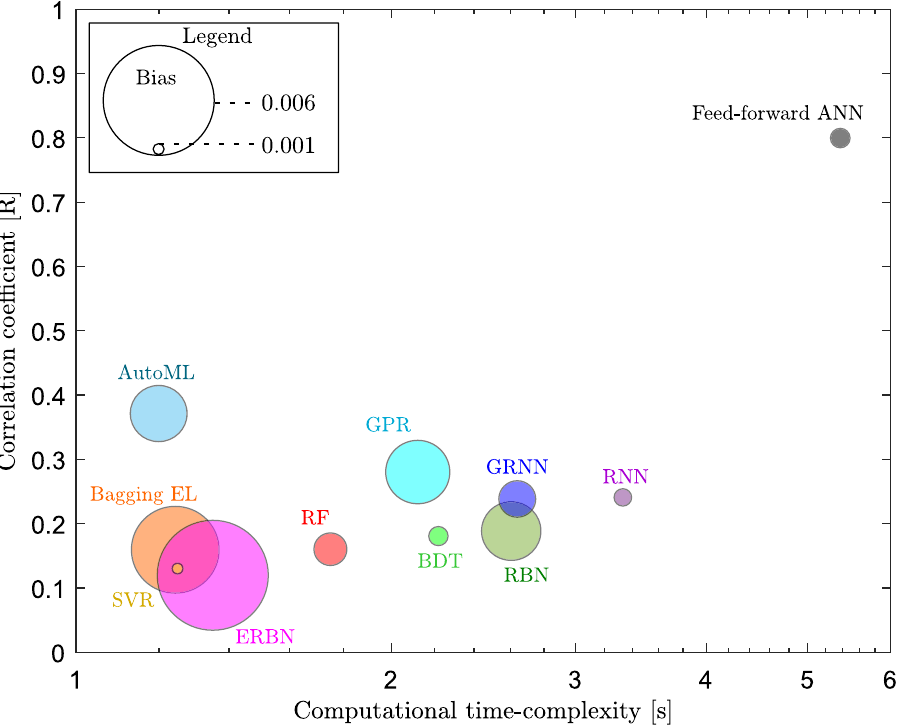
Figure 11. Comparison of the computational time complexity and performance of the benchmark algorithms (each represented in a different colour). The radius of the circle represents the magnitude of the bias for each model.